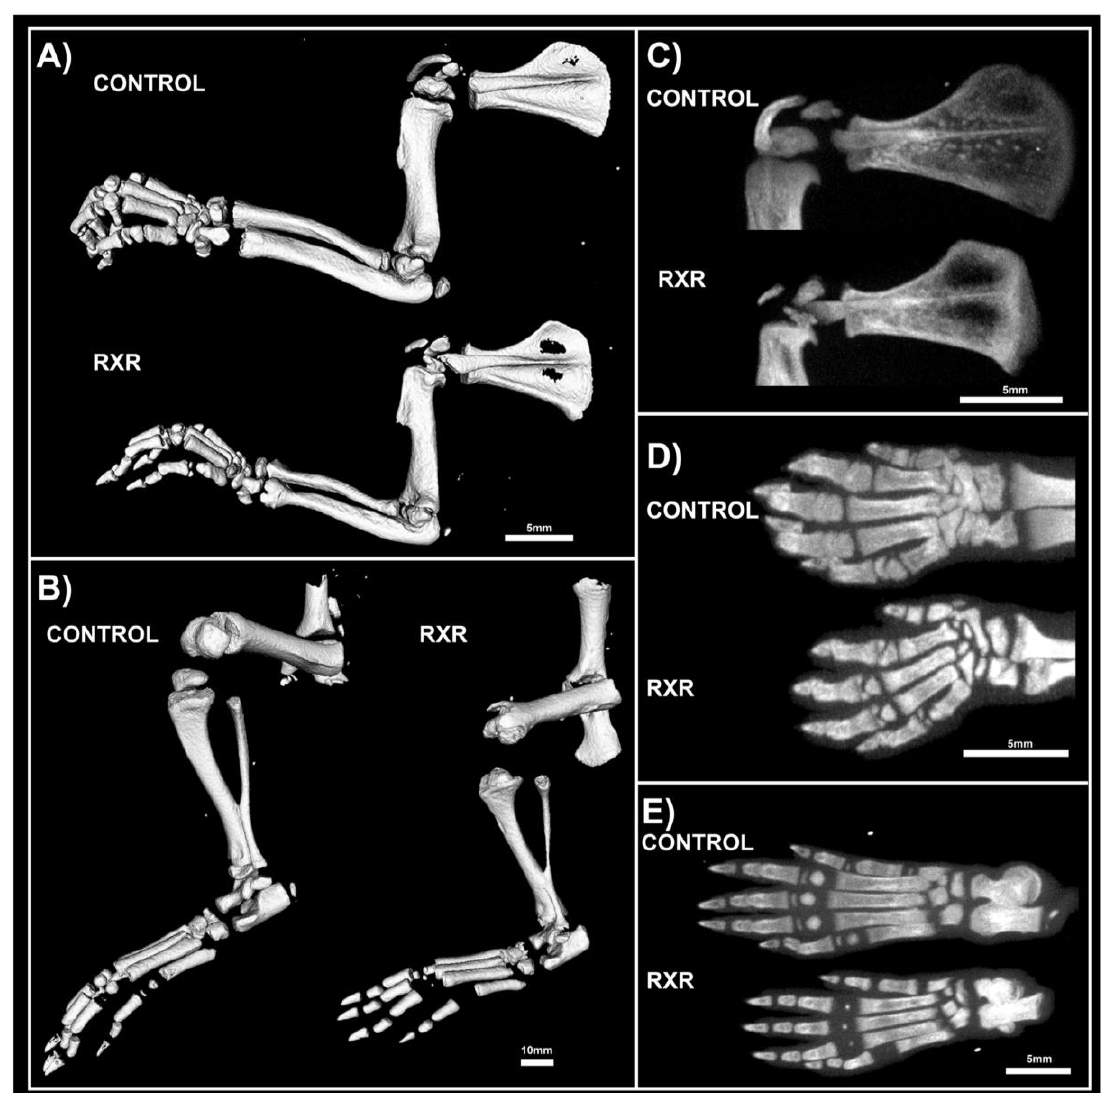
Figure 3. microCT ( µ CT) Images of P16 RXR and control male rats show abnormal morphology. Fore- and hindlimbs bones of control rats were longer and thicker than those of RXR agonist-treated animals ( A , B ). The scapulae of RXR agonist-treated animals had increased radio-opacity in the center of the bone, but more calcification along the outer edges when compared to those of the animals treated with DMSO ( C ). The metacarpals and metatarsals of the hands and feet appeared dysmorphic, under-calcified, and under-developed in the animals treated with the RXR agonist ( D , E ) ( N = 5; 50 micrometers/voxel).